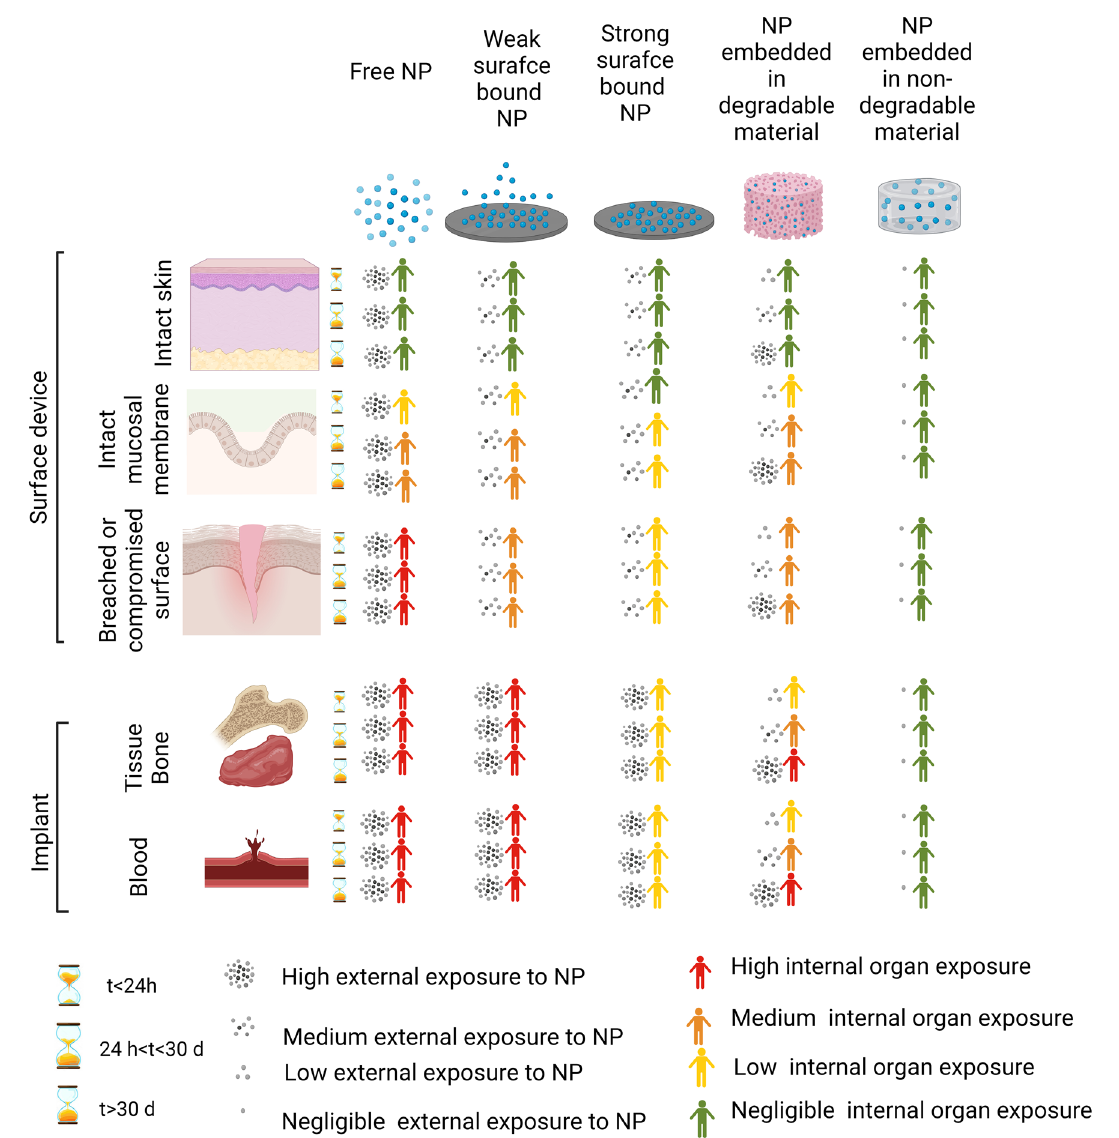
Fig. 1 Risk evaluation of nanomedicine devices based on estimation of internal and external exposure. Based on the type of organ, duration of exposure of nanomaterials, and their physicochemical characteristics, humans can be subject to negligible or high internal exposure to nanoma- terials. The figure is drawn based on the data provided in the Scientific Committee on Emerging and Newly Identified Health Risks (SCENIHR) report entitled “Guidance on the determination of potential health effects of nanomaterials used in medical devices”